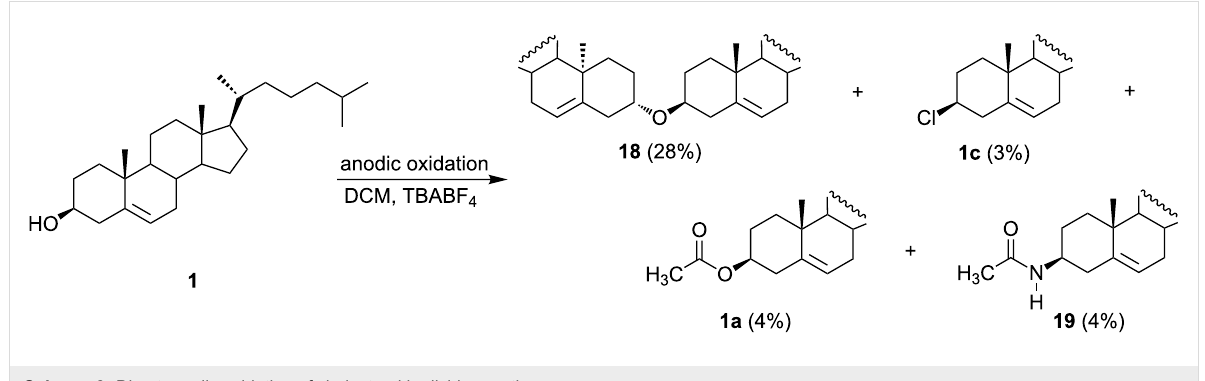
Scheme 8: Direct anodic oxidation of cholesterol in